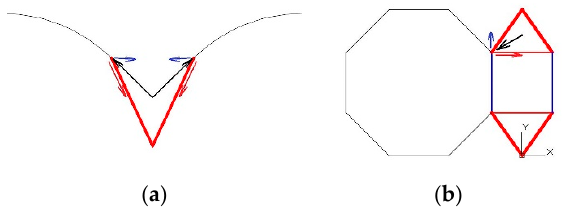
Figure 5. ( a ) Diagram in section view of the operation of the vault thrust; ( b ) diagram in plan view of the operation of the vault thrust.